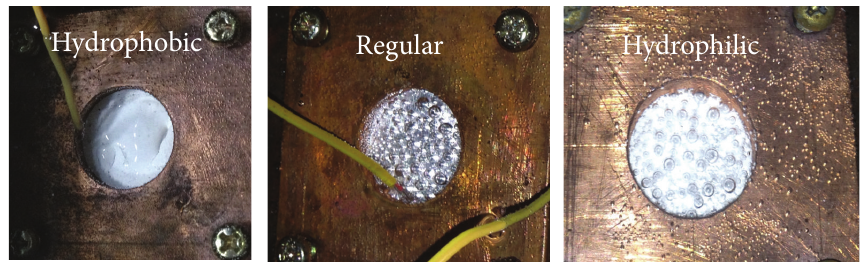
Figure 8: Film or bubbles formed during boiling heat transfer for different wettability